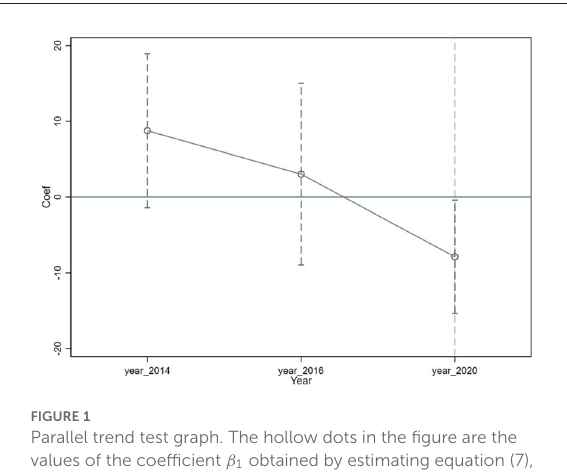
FIGURE1 Parallel trend test graph. The hollow dots in the figure are the values of the coefficient β 1 obtained by estimating equation (7), and the dotted lines indicate the 99% confidence interval. The estimation method uses a two-way fixed effects model and robust standard errors for clustering at the district and county